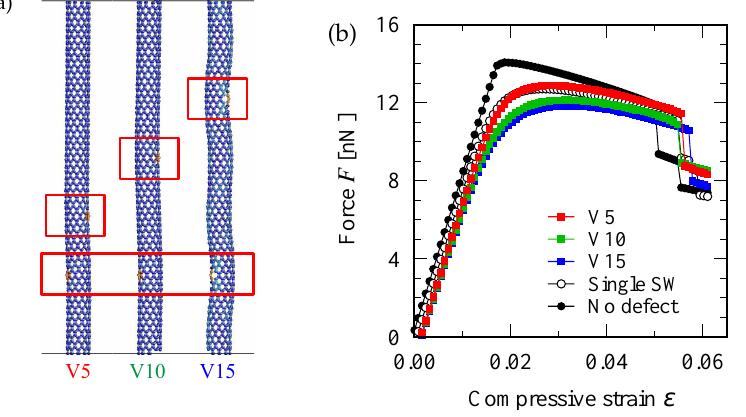
Figure 7. ( a ) Configuration of the two SW defects. The defect position is shifted in the direction vertical to the circumference of the tube. ( b ) Force-strain curve for the different defect configurations. The critical points of almost all defective curves are below that of the one-SW-defect